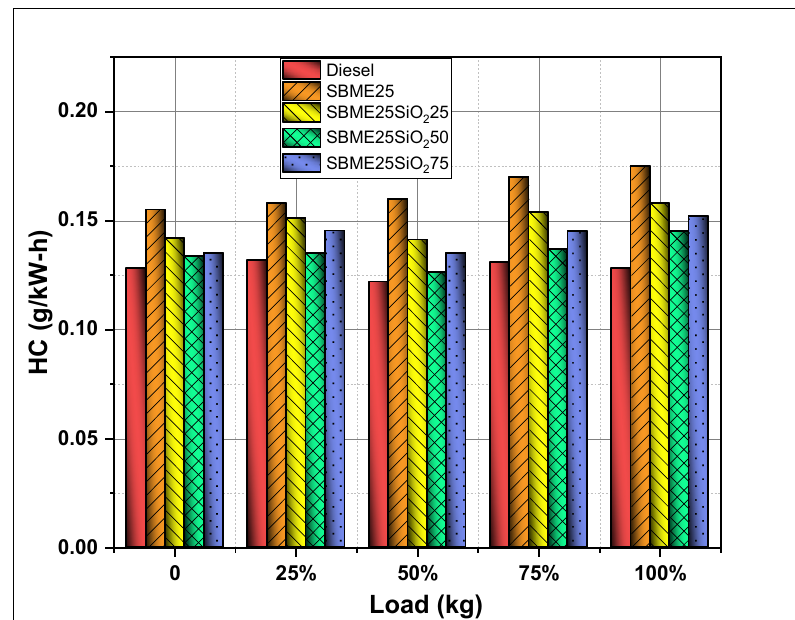
Figure 11. Effect of SiO 2 nano-additives on hydrocarbon (HC) at varying load.